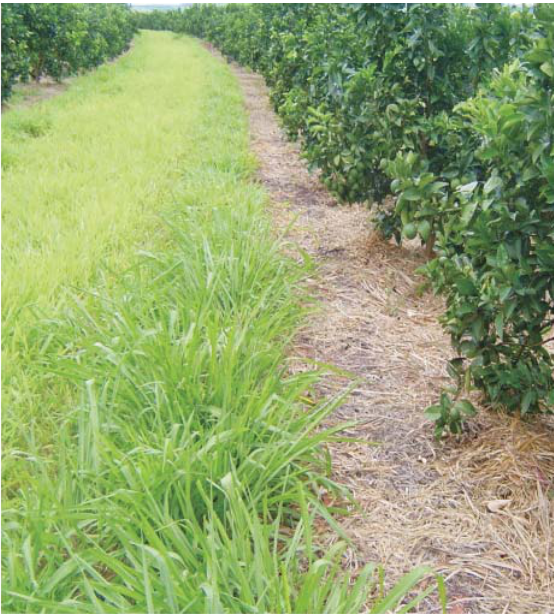
Figure 1. Mulch management systems in a “Pêra” orange orchard cultivated with Brachiaria brizantha grass (Pedro Antonio Martins Auler -